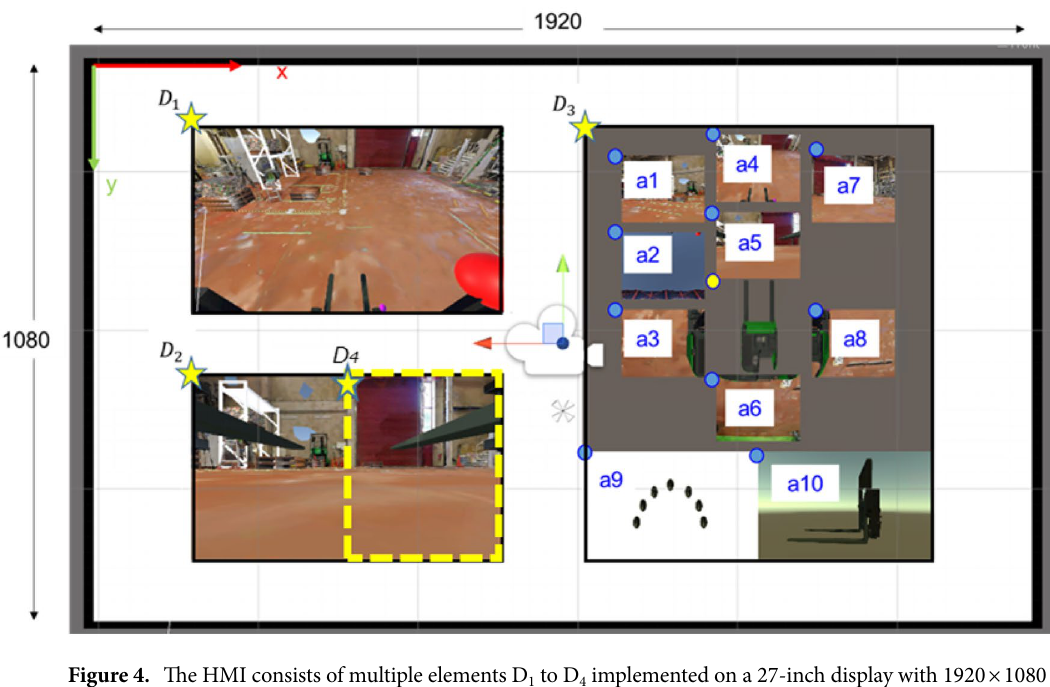
Figure 4. The HMI consists of multiple elements D 1 to D 4 implemented on a 27-inch display with 1920 × 1080 resolution (see Appendix B for the details of cameras mounted on the forklift which provide the views for UI elements a1 to a8).